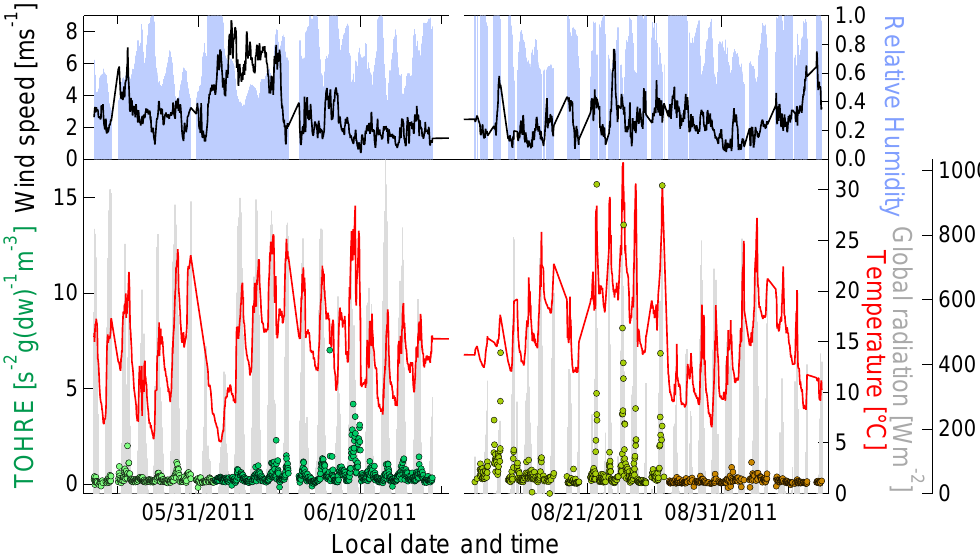
Fig. 4. Overview of the entire data set: total OH reactivity emission rates (TOHRE, green markers) were measured from 24May to 14June2011 and 12 August to 7 September 2011, covering the seasonal impact from spring to early autumn. Temperature inside the cuvette (red line) and global radiation from a colocated mast (grey area) showed high variability throughout the measurement period as well as wind speed (black line, top panel) and relative humidity (blue area, top panel). Table 2. Average values for meteorological parameters, total OH reactivity emissions (TOHRE), the single-compound total OH reactivity emissions of monoterpenes (MTOHRE), isoprene (IOHRE) and acetaldehyde (AOHRE) and the unknown fraction of TOHRE (missing TOHRE). Data were averaged for the entire measurement period (all), for 24 May–31 May 2011 (spring), 1 June–14 June 2011